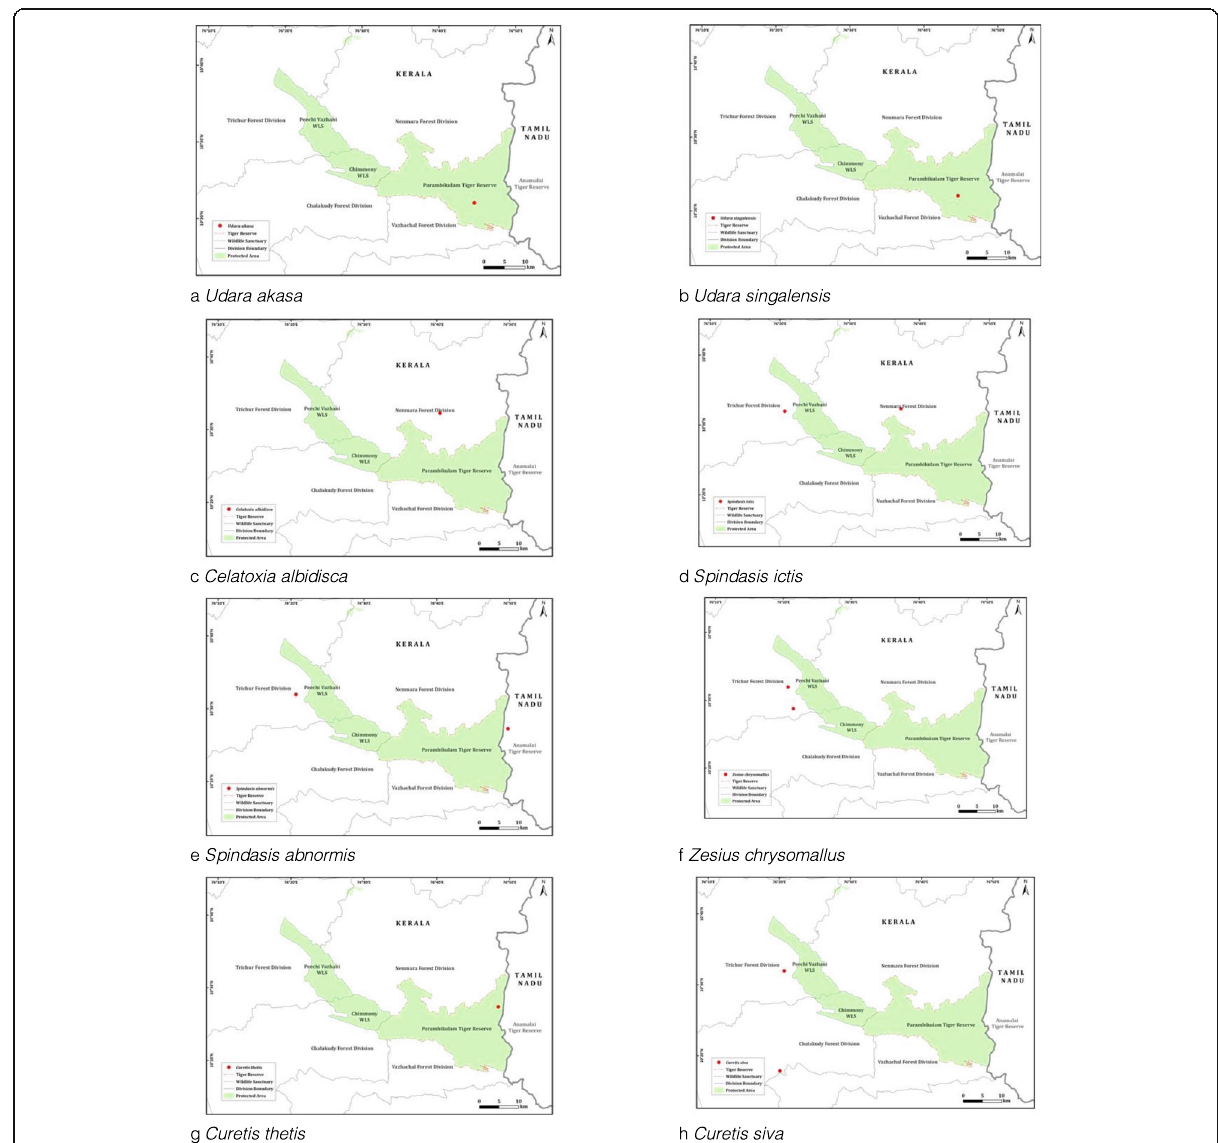
Fig. 6 a - h Distribution maps of endemic butterflies of family Lycaenidae within study area. a Udara akasa . b Udara singalensis . c Celatoxia albidisca . d Spindasis ictis . e Spindasis abnormis . f Zesius chrysomallus . g Curetis thetis . h Curetis